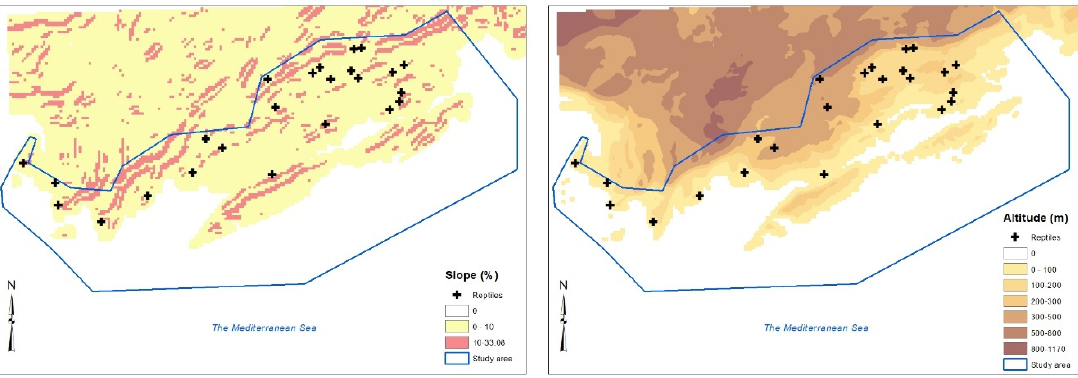
Figure 8. The distributions of vulnerable reptiles and amphibians (Table 1) observed during the field works on the slope (left) and altitude range (right) maps.